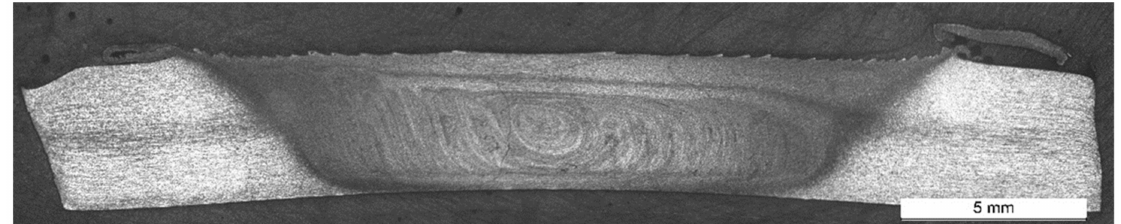
Figure 10. Microsection after 200 mm weld